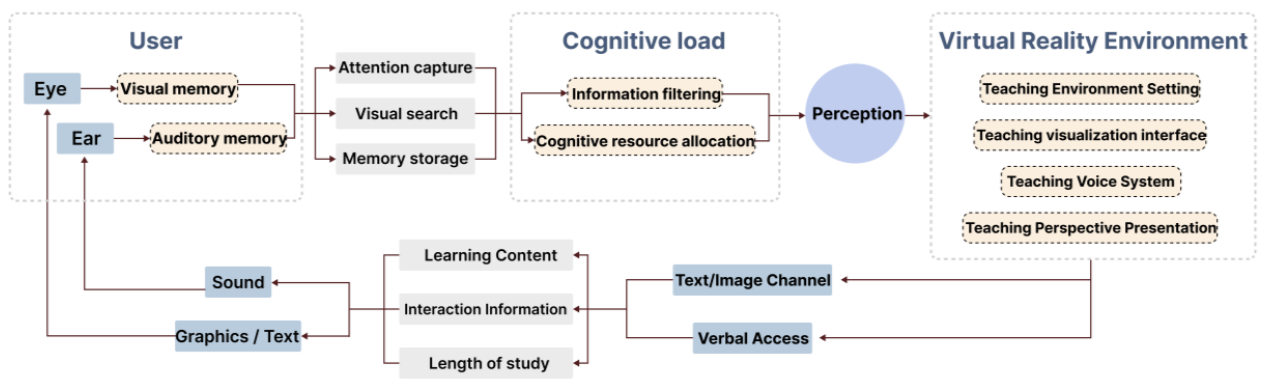
Figure 2. Teaching information processing model of user and virtual reality environment (HCI).